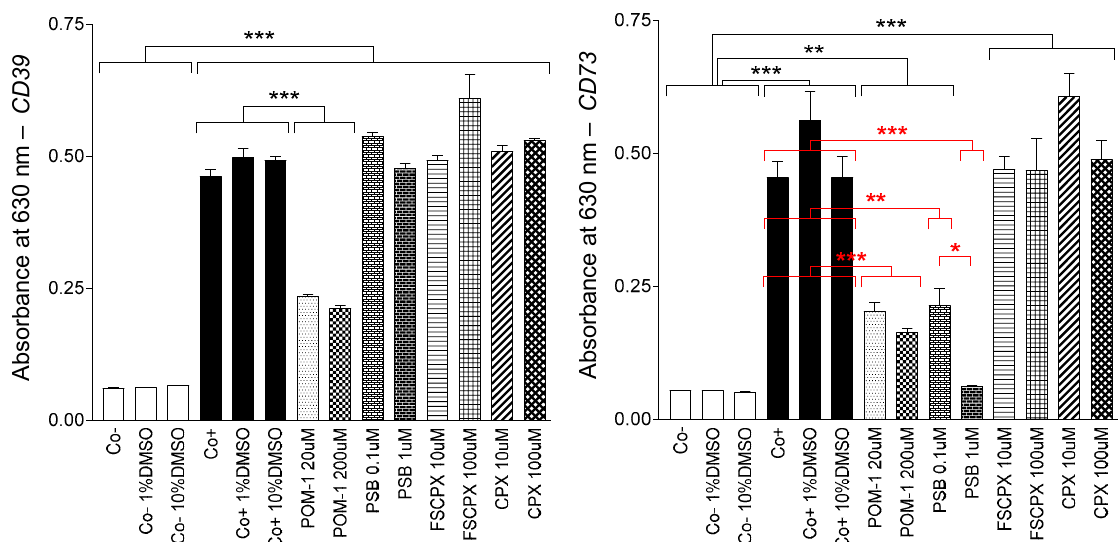
Figure 2. Absorbance at 630 nm measured in two 96-well microplates to quantify the activity of CD39 ( left panel ) and CD73 ( right panel ) enzymes (+SEM). For both kits, 14 sorts of mixtures were prepared (each one in four or eight wells). Co-: negative control (“blank”); Co- 1%DMSO: negative control containing 1% DMSO; Co- 10%DMSO: negative control containing 10% DMSO; Co+: positive control; Co+ 1%DMSO: positive control containing 1% DMSO; Co+ 10%DMSO: positive control containing 10% DMSO; POM-1 20 uM: inhibitor control with 20 μ M POM-1; POM-1 200 uM: inhibitor control with 200 μ M POM-1; PSB 0.1 uM: inhibitor control with 0.1 μ M PSB-12379; PSB 1 uM: inhibitor control with 1 μ M PSB-12379; FSCPX 10 uM: inhibitor test of 10 μ M FSCPX; FSCPX 100 uM: inhibitor test of 100 μ M FSCPX; CPX 10 uM: inhibitor test of 10 μ M CPX; CPX 100 uM: inhibitor test of 100 μ M CPX; *: comparison of the sorts of mixtures indicated; the number of marks means the level of statistical significance (one mark: p < 0.05, two marks: p < 0.01, three marks: p < 0.001).